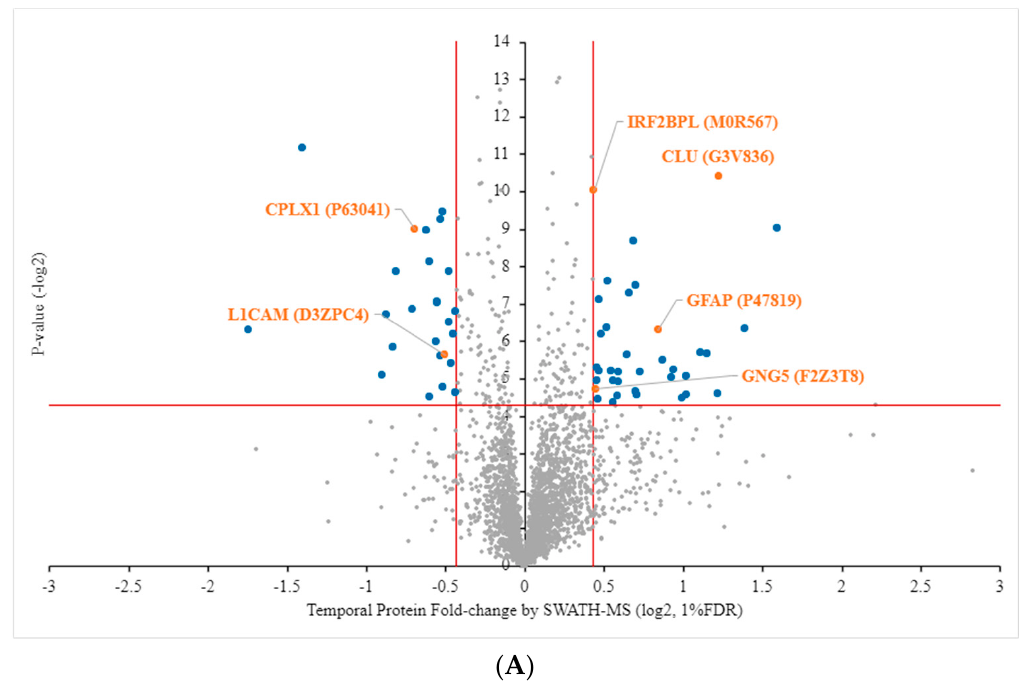
Table 1. Protein and peptide identification in retinal samples 2 weeks after pONT.